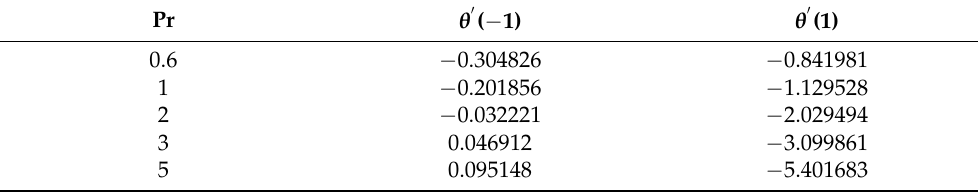
Table 9. Heat transfer rate for different Pr.